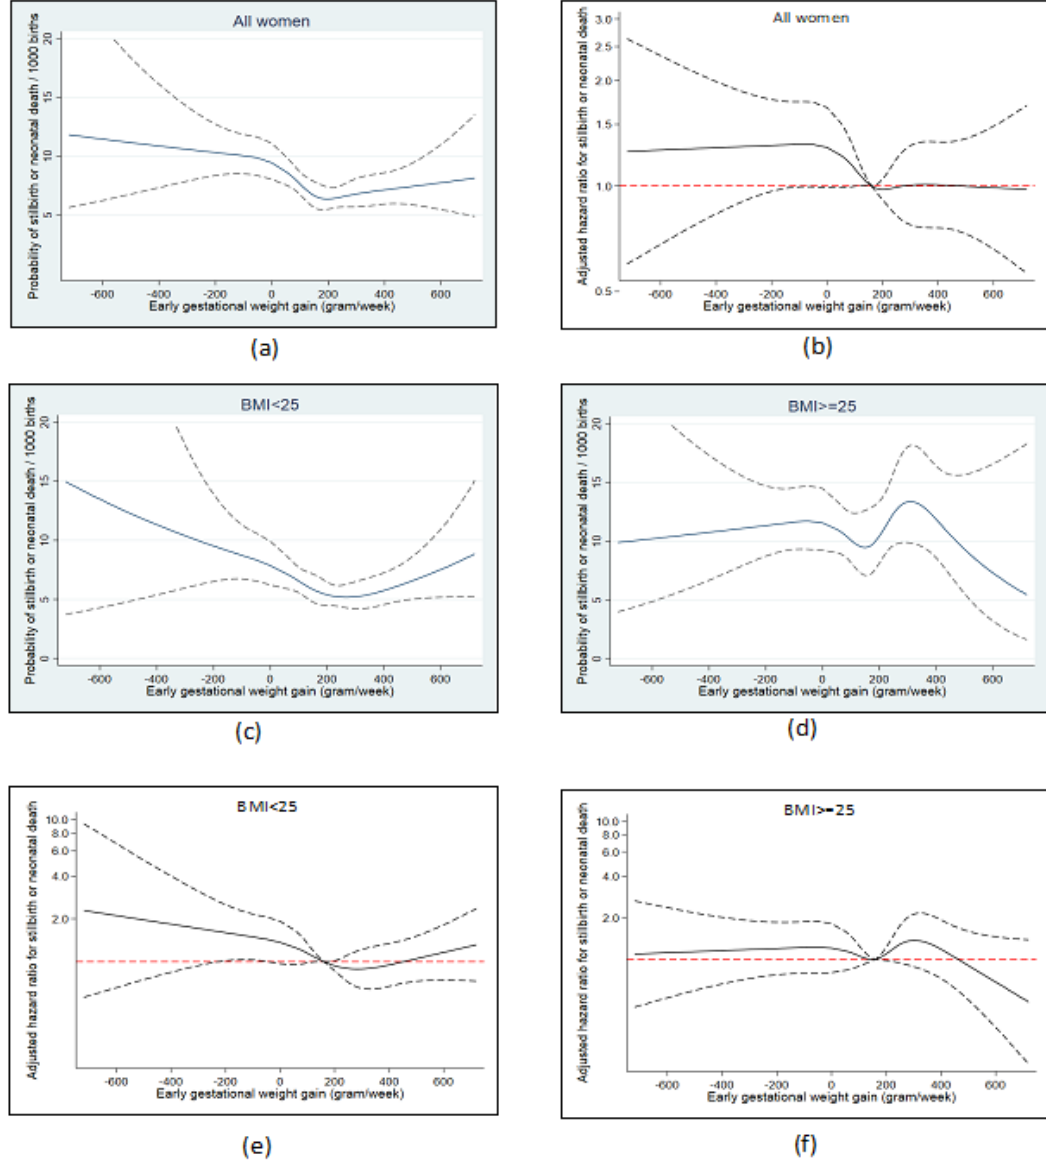
Figure 2. Absolute risks and adjusted hazard ratios for stillbirth or neonatal death according to early gestational weight gain in all women ( a , b ) and in women with BMI < 25 ( c , e ) and BMI ≥ 25 ( d , f